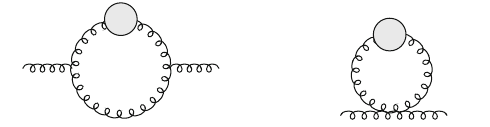
Fig. 2 IRdivergentcontributionstothe2-loopself-energyofthegauge field. The blob represents the 1-loop correction